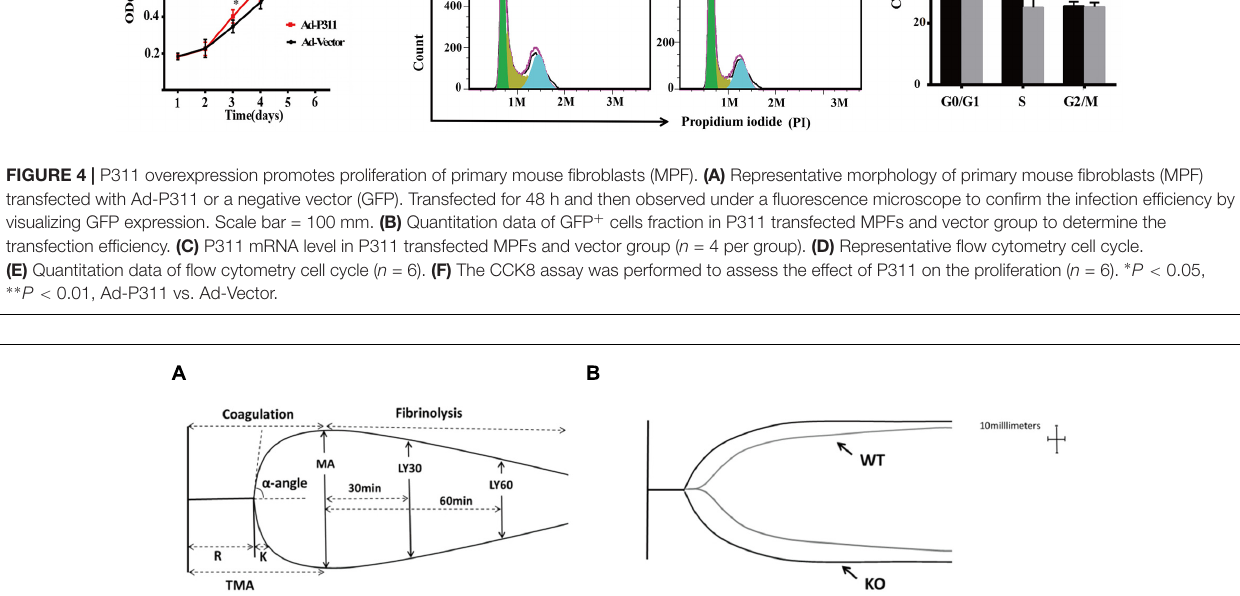
FIGURE 5 | The impact of P311 knock-out on murine blood coagulation. (A) A schematic TEG tracing. The parameters are described in Table 1 . (B) Quantitation of the neo-epidermal length ( n = 6). Representative TEG tracing from a P311 WT-burn mouse (gray line) and P311 KO-burn mouse (black line). The details of the result of TGE analysis is showed in Table 2